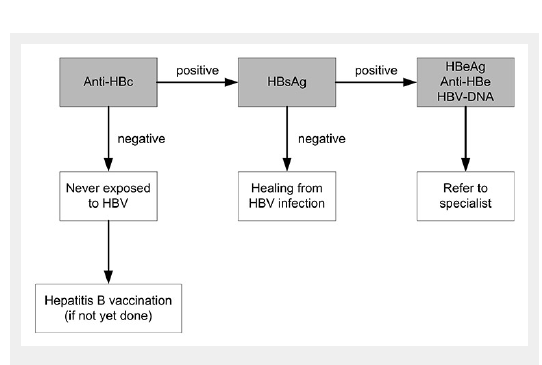
Testing for chronic hepatitis B virus (HBV) infection: absence of anti-HBc excludes HBV infection, while the presence of HBsAg indicates ongoing infection. Anti-HBc = antibody to hepatitis B core antigen; Anti-HBe = antibody to hepatitis B ‘e’ antigen, HBeAg = hepatitis B ‘e’ antigen; HBsAg = hepatitis B surface antigen; HBV DNA = HBV deoxyribonucleic